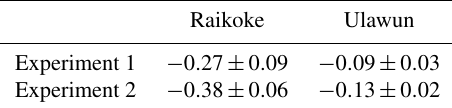
Table 2. Global clear-sky TOA RF estimations (in Wm − 2 ). Exper- iment 1: using shortwave SSA between 0.97 and 1.0 and shortwave g between 0.50 and 0.85; Experiment 2: using shortwave SSA